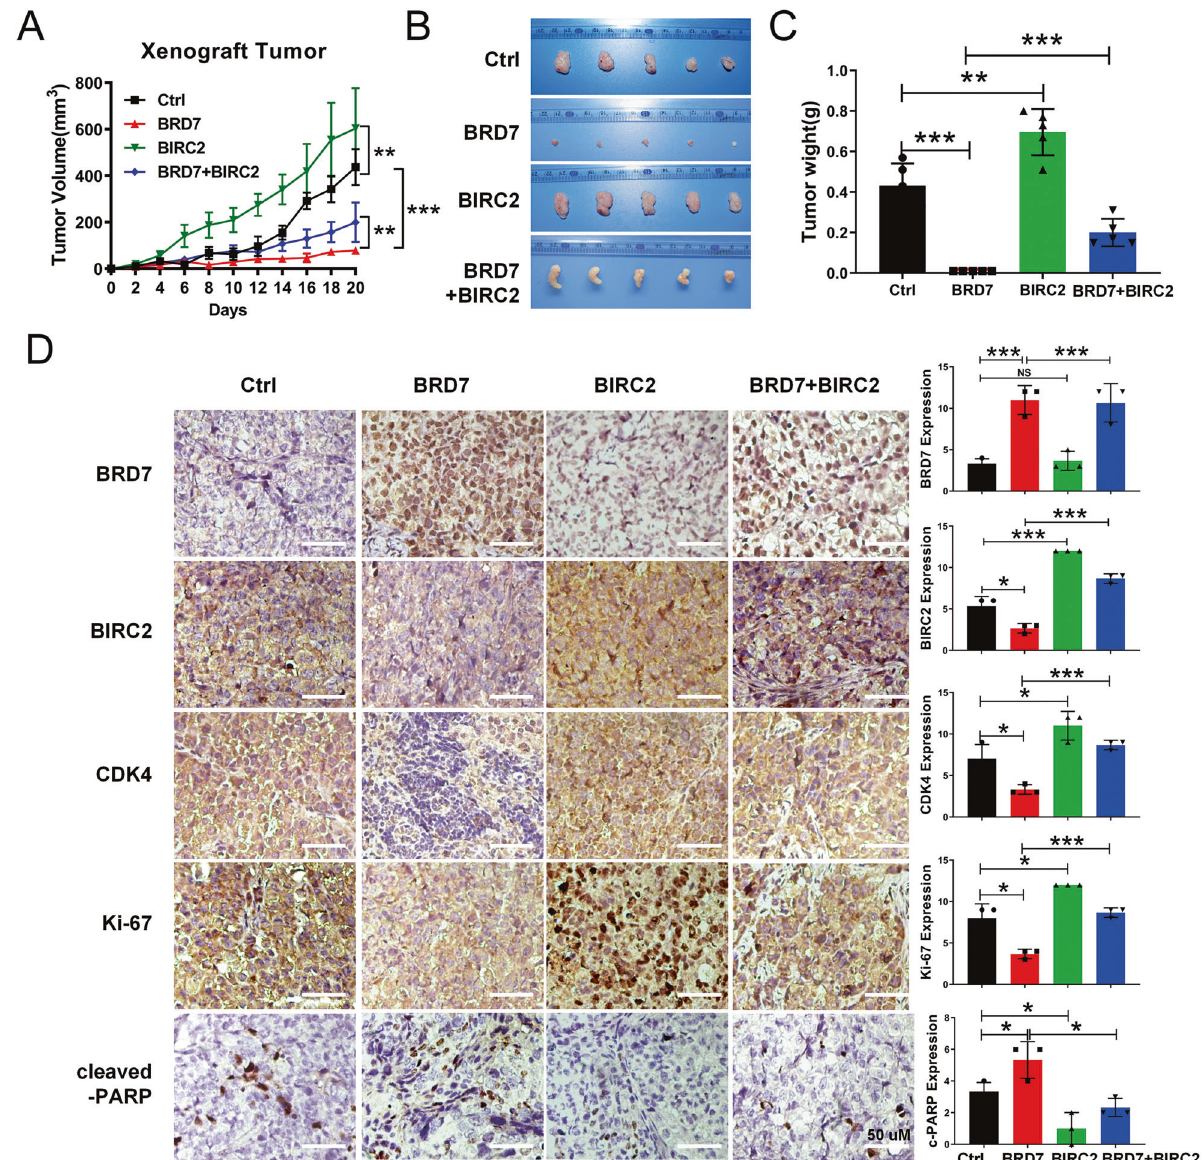
Fig. 6 BRD7 inhibits tumor growth in vivo through regulation of BIRC2 expression. A Growth curve of tumor xenografts. B Representative tumor images of the 5-8 F xenograft model in nude mice. C Tumor weight quanti fi cation. D IHC (DAB staining) for Ki-67, CDK4 and cleaved- PARP in the 5-8 F xenograft model. Three tumors were analyzed per group. Original magni fi cation, 200×; scale bars represent 50 μ m. Error bars represent the mean ± SD. *P < 0.05, **P < 0.01, ***P <